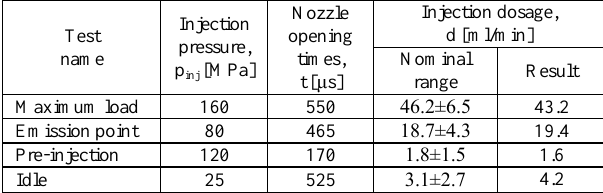
Table 3. Results of the main fuel injector flow